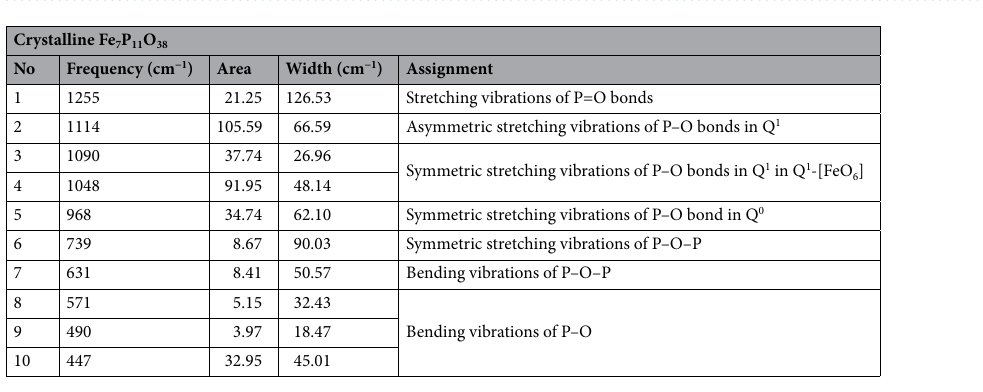
Table 2. Fitted Raman spectra of the components of Fig. 4 11,41–43